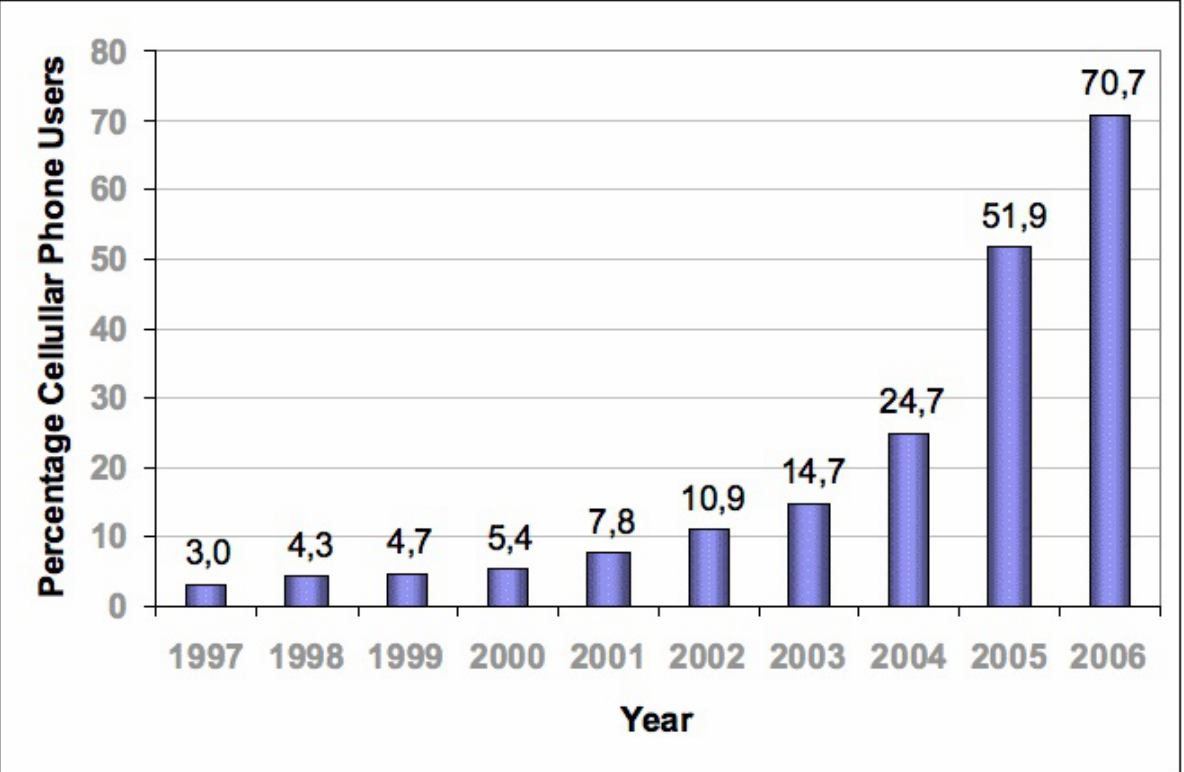
Figure 4. Penetration of mobile phones in Colombia